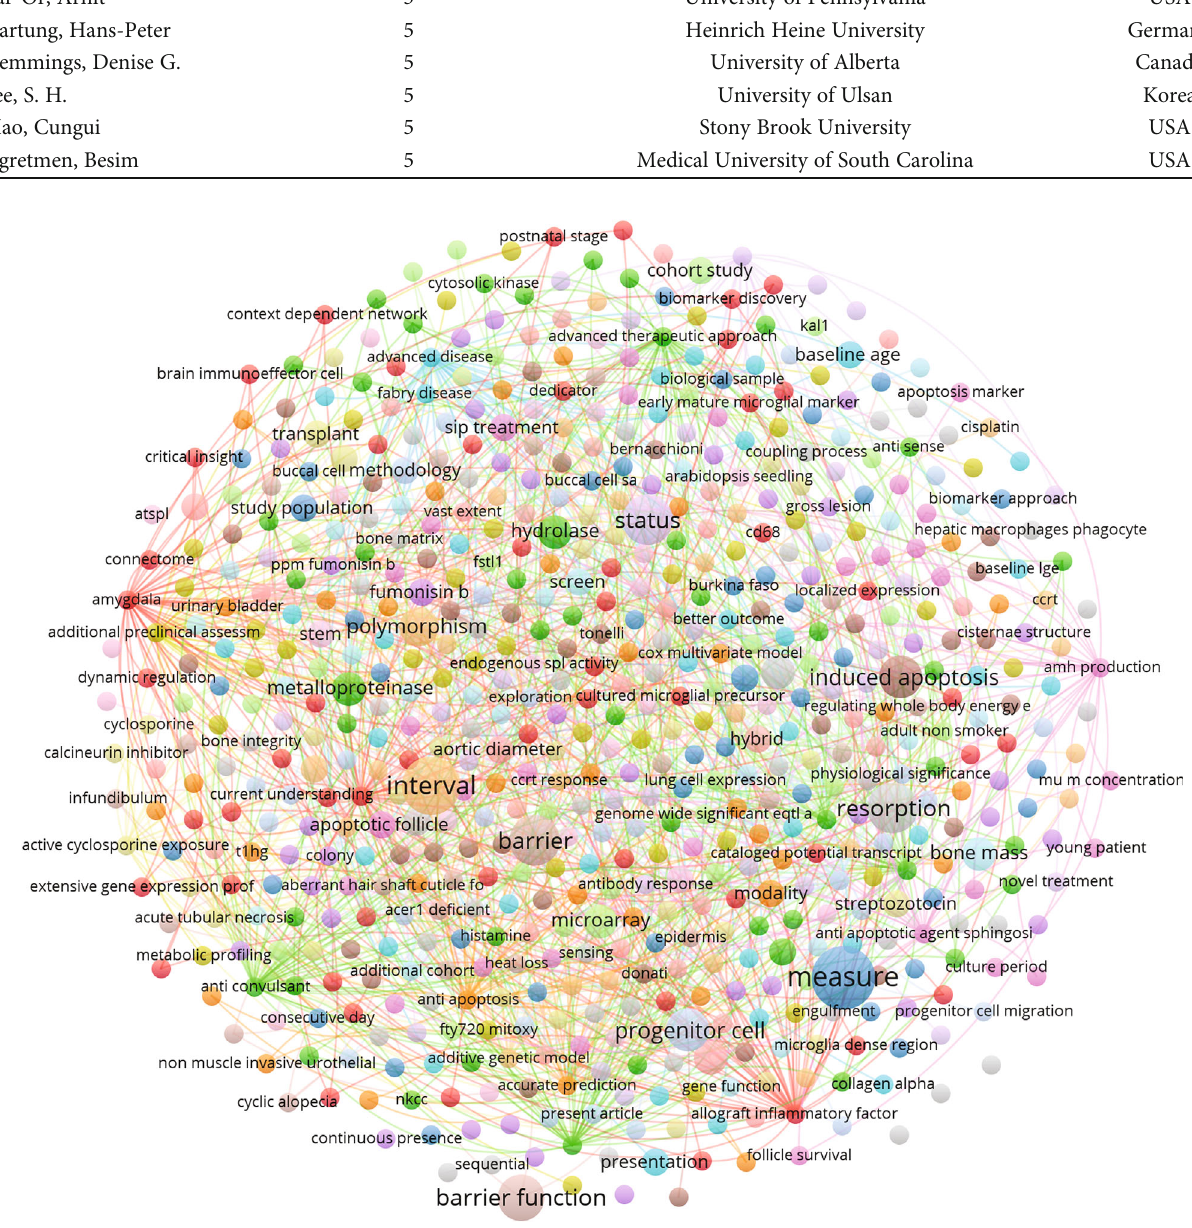
Figure 6: Keywords map in S1P and age-related